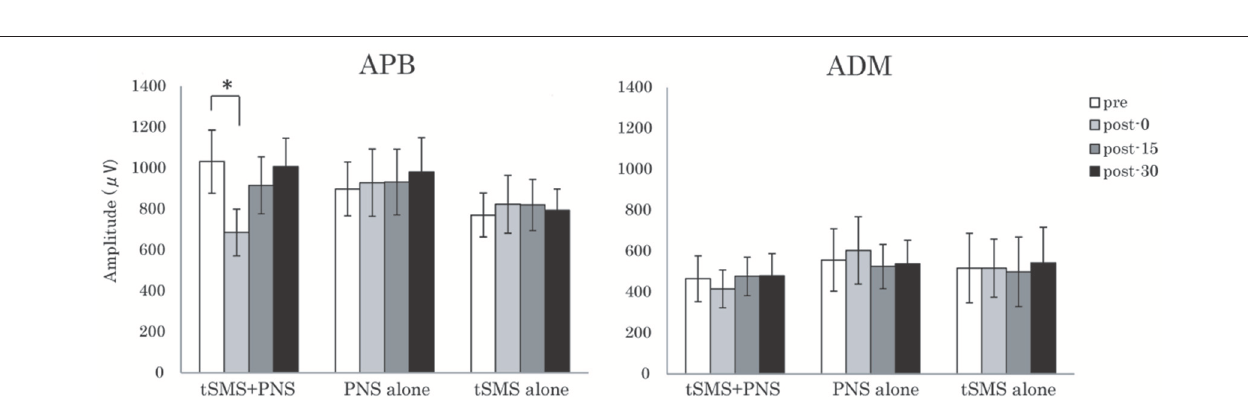
FIGURE 2 | Effects of the combination of tSMS and PNS on the MEP amplitude measured in the right APB and ADM muscles. The mean MEP amplitude in APB muscle was significantly decreased immediately after the intervention combining tSMS and PNS but not after the other sham condition. * p < 0.05 between pre and post-0. Error bars are standard errors of the